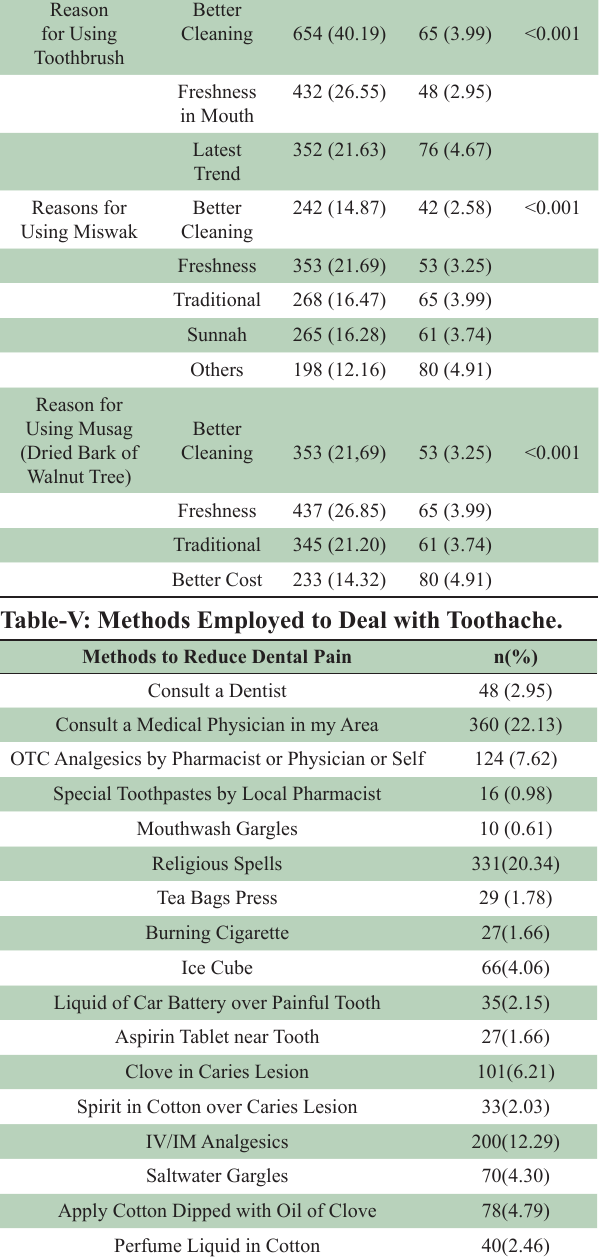
self-dental care methods opted by rural people in